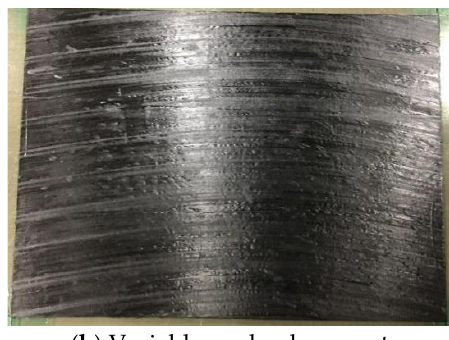
Figure 7. Laying process of laminate.